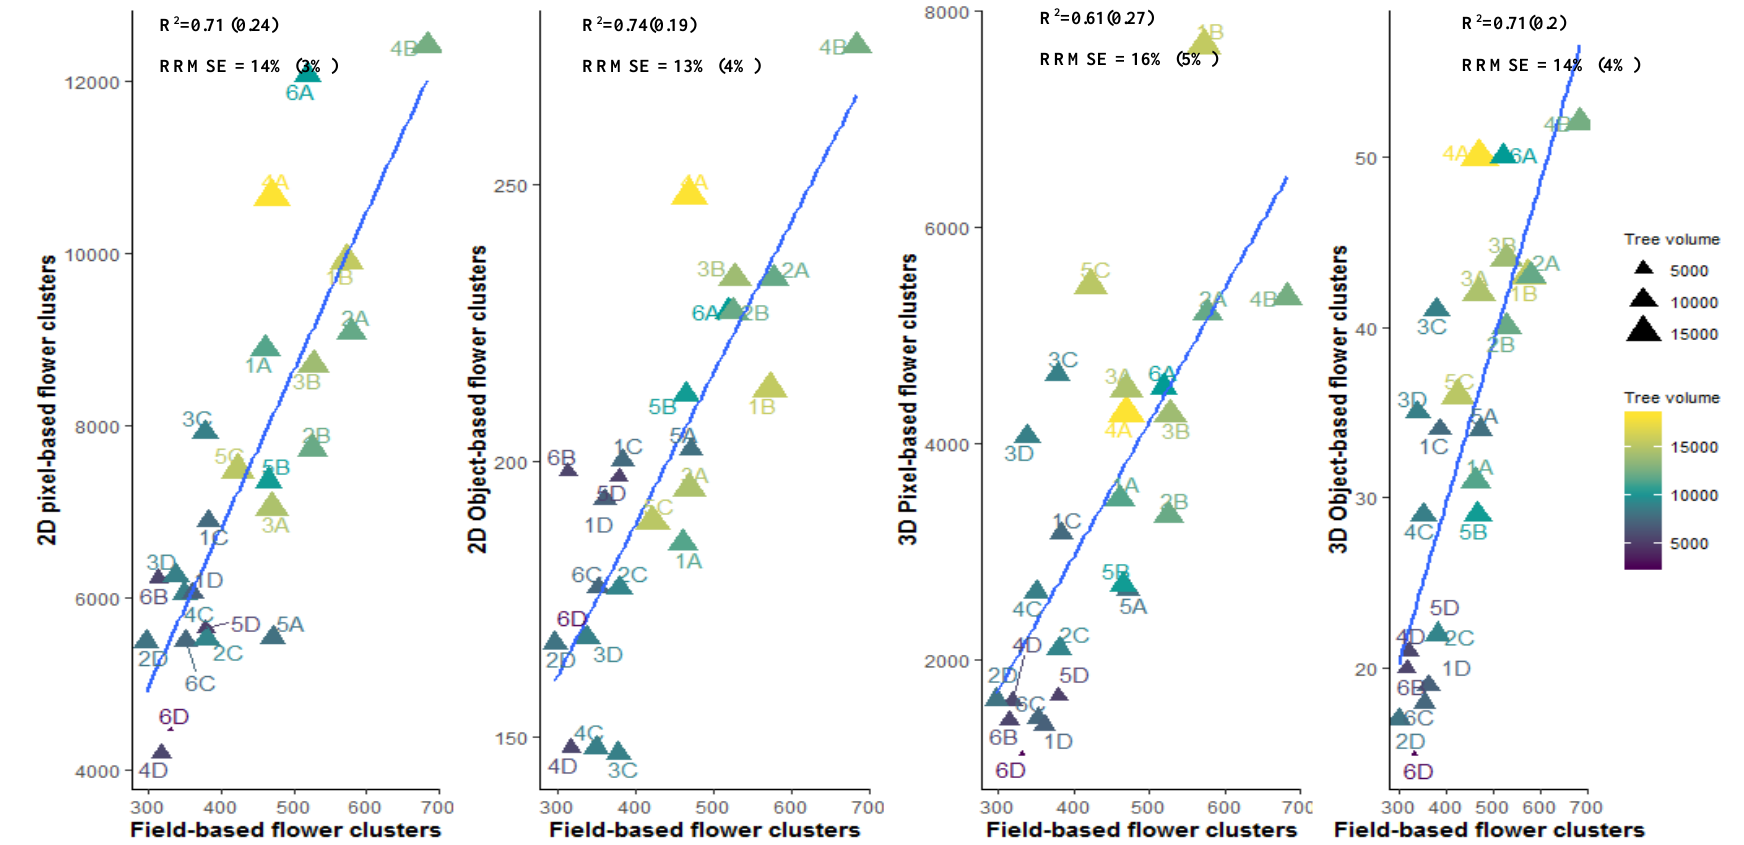
Figure 5. Correlation plots of Rummen between the field-based flower clusters on plot level and the four retrieval models (i.e., 2D pixel-based flower clusters, 2D object-based flower clusters, 3D pixel-based flower clusters and 3D object-based flower clusters); the tree volume in cm 3 is visualized by the symbol size and color of the datapoints.